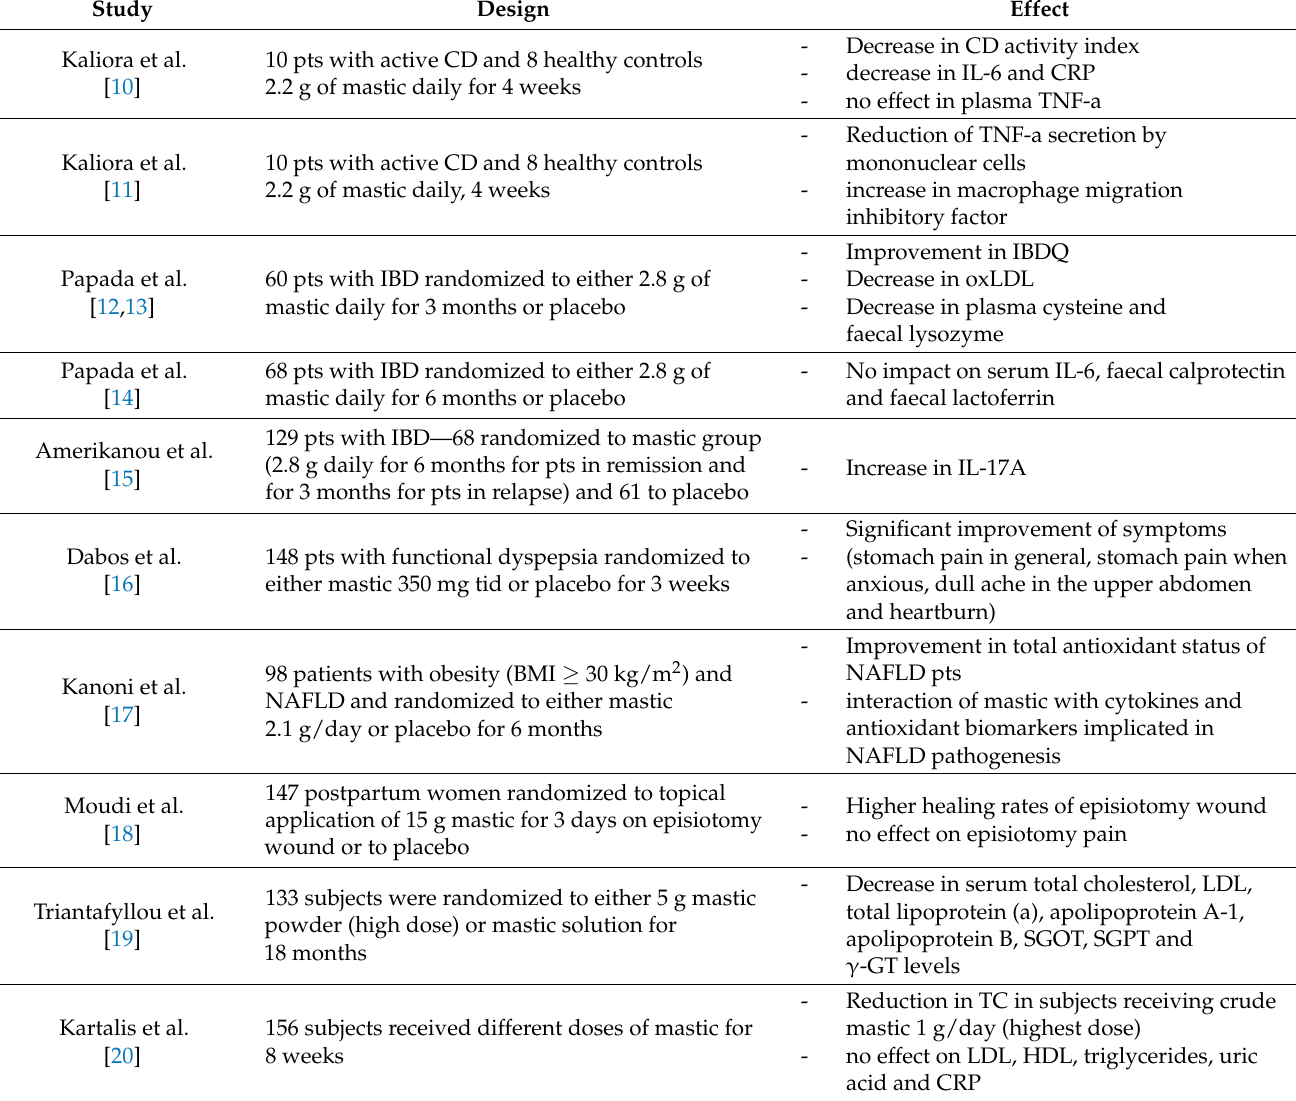
Table 2. Human studies assessing mastic’s